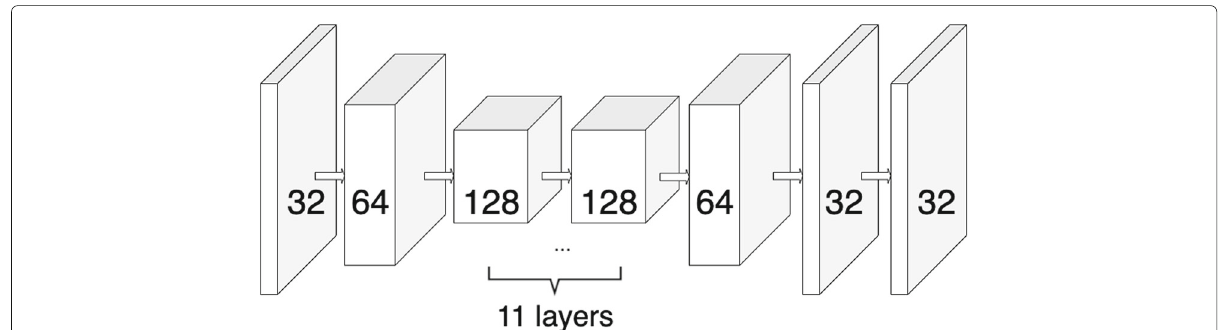
Fig. 2 Autoencoder schema. Simple diagram of the CNN-based autoencoder. The numbers represent the filters count per each